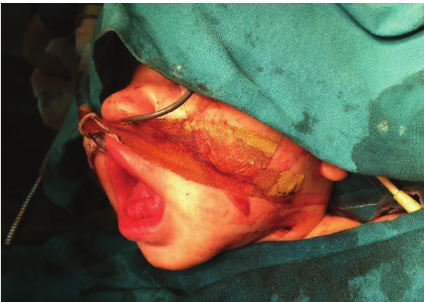
Figure 5: Marked reduction in the size of the mouth after excision of the cyst.